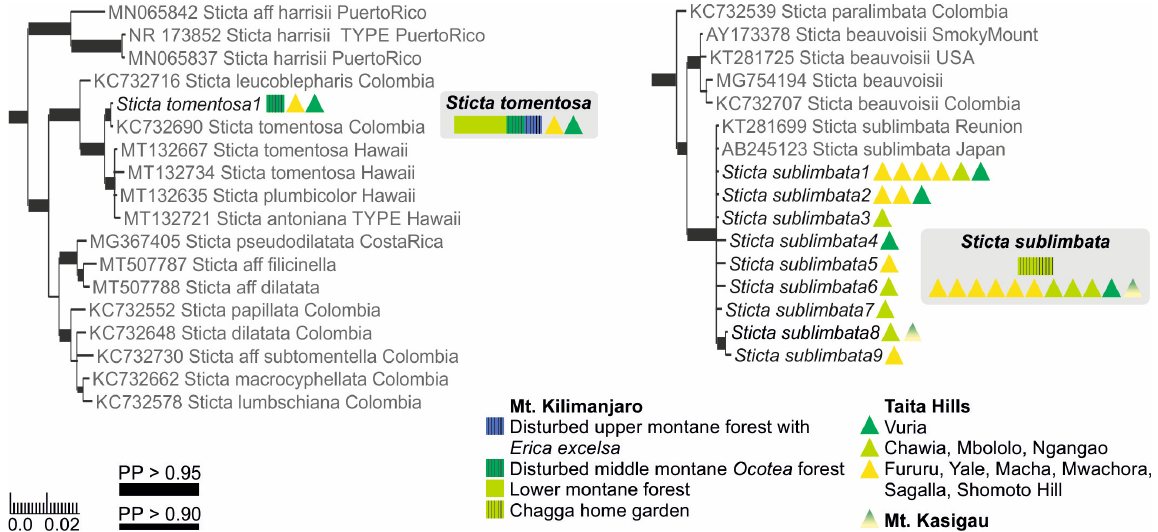
Figure 1. Clades with Sticta tomentosa and S. sublimbata of the Bayesian tree of the genus Sticta based on the nuITS marker region (Figure S1A,B). The colored polygons (rectangle, triangle) in the tree show the distribution of the ITS variants in the studied regions and ecosystem types: On Mt. Kili- manjaro, the different habitats are indicated by color and grid; the width of the rectangle indicate the number of sample plots in which the taxon was present in each ecosystem type (square = 1). In the Taita Hills, each triangle indicates presence in one forest fragment and on Mt. Kasigau in one sampling transect. The grey boxes show the total abundance and distribution of the species, also including the data from unsequenced specimens. Stronger support (PP > 0.9) for a clade is indicated with a thicker branch. The scale refers to nucleotide substitutions per site. 3.1.2. Fertile Specimens without Symbiotic Propagules Three frequently fertile Sticta species that lack symbiotic propagules had previously been reported from the region, i.e., S. ambavillaria , S. kunthii , and S. tomentosa [12,26], and specimens resembling the descriptions of all these taxa were also present in our material. All specimens matching the de- scription of S. tomentosa fell into a well-supported (PP = 1) clade, which mainly consists of S. tomen- tosa specimens from Colombia and Hawaii (Figure 1). All other specimens belonged to the S. umbil- icariiformis — fuliginosa group (Figure 2). In the additional analysis, six specimens formed a well-sup- ported (PP = 0.992) clade ( S. munda ); however, many morphologically similar specimens, i.e., fertile with pubescent or nodulous apothecial margins and with smooth, scrobiculate, foveolate to pitted upper surface, were mainly placed in the poorly resolved S . umbilicariiformis group, with some spec- imens in the well-supported (PP = 1) S. aspratilis clade.